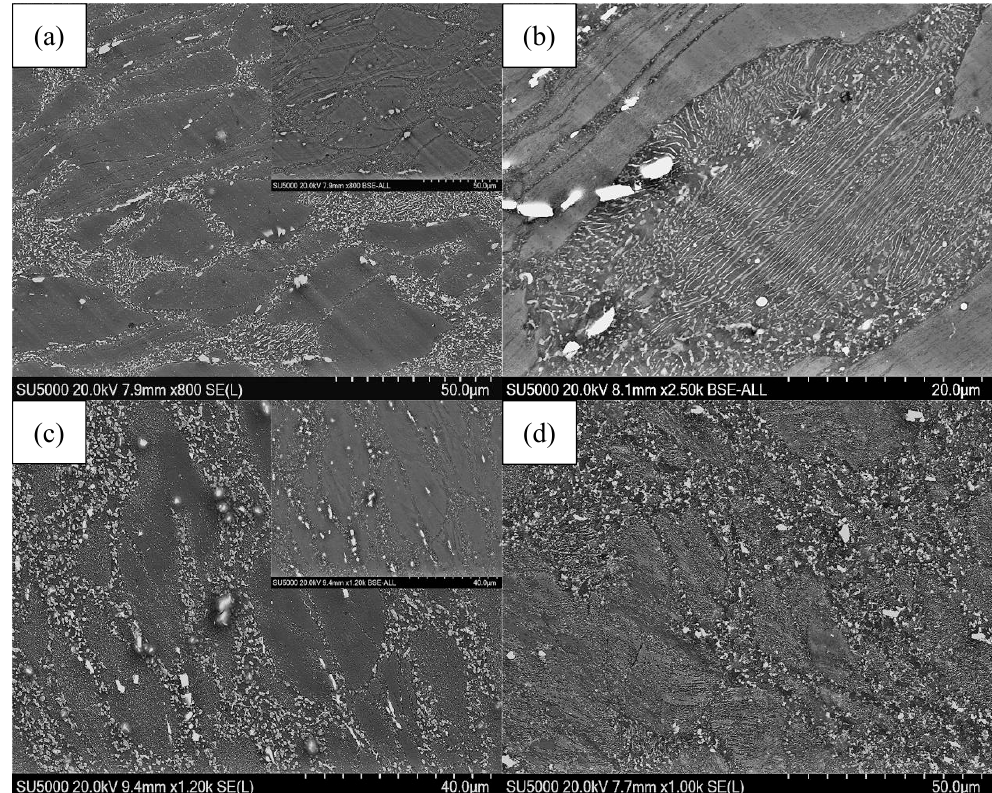
Figure 7. SEM images of AZ80 + 0.4%Ce magnesium alloys after deformation at 240 °C with different passes: ( a ) 0 pass (extrusion), ( b ) local enlarged drawing of white region in ( a ), ( c ) first pass (extension), ( d ) fourth pass (extension).